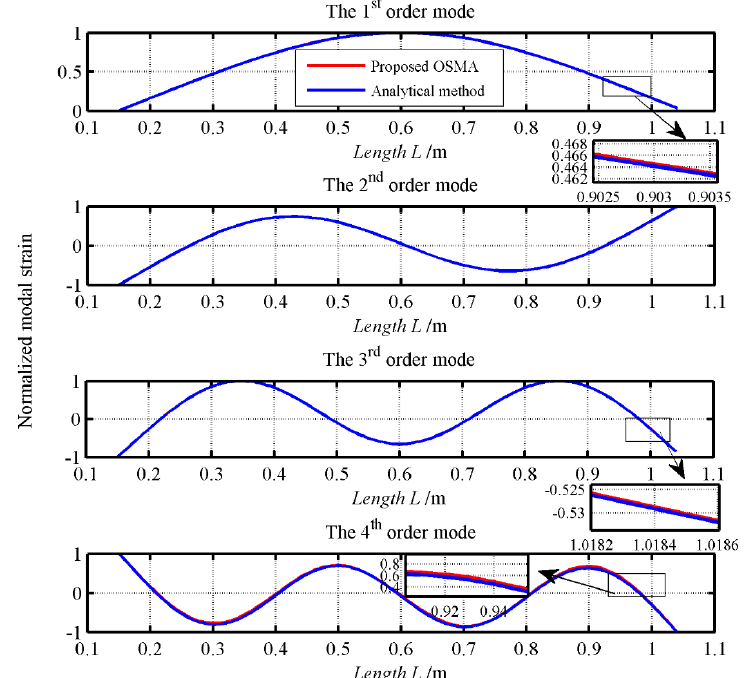
Figure 4. The comparison of the strain mode shapes identified from the OMA and the results calculated from the analytical method.